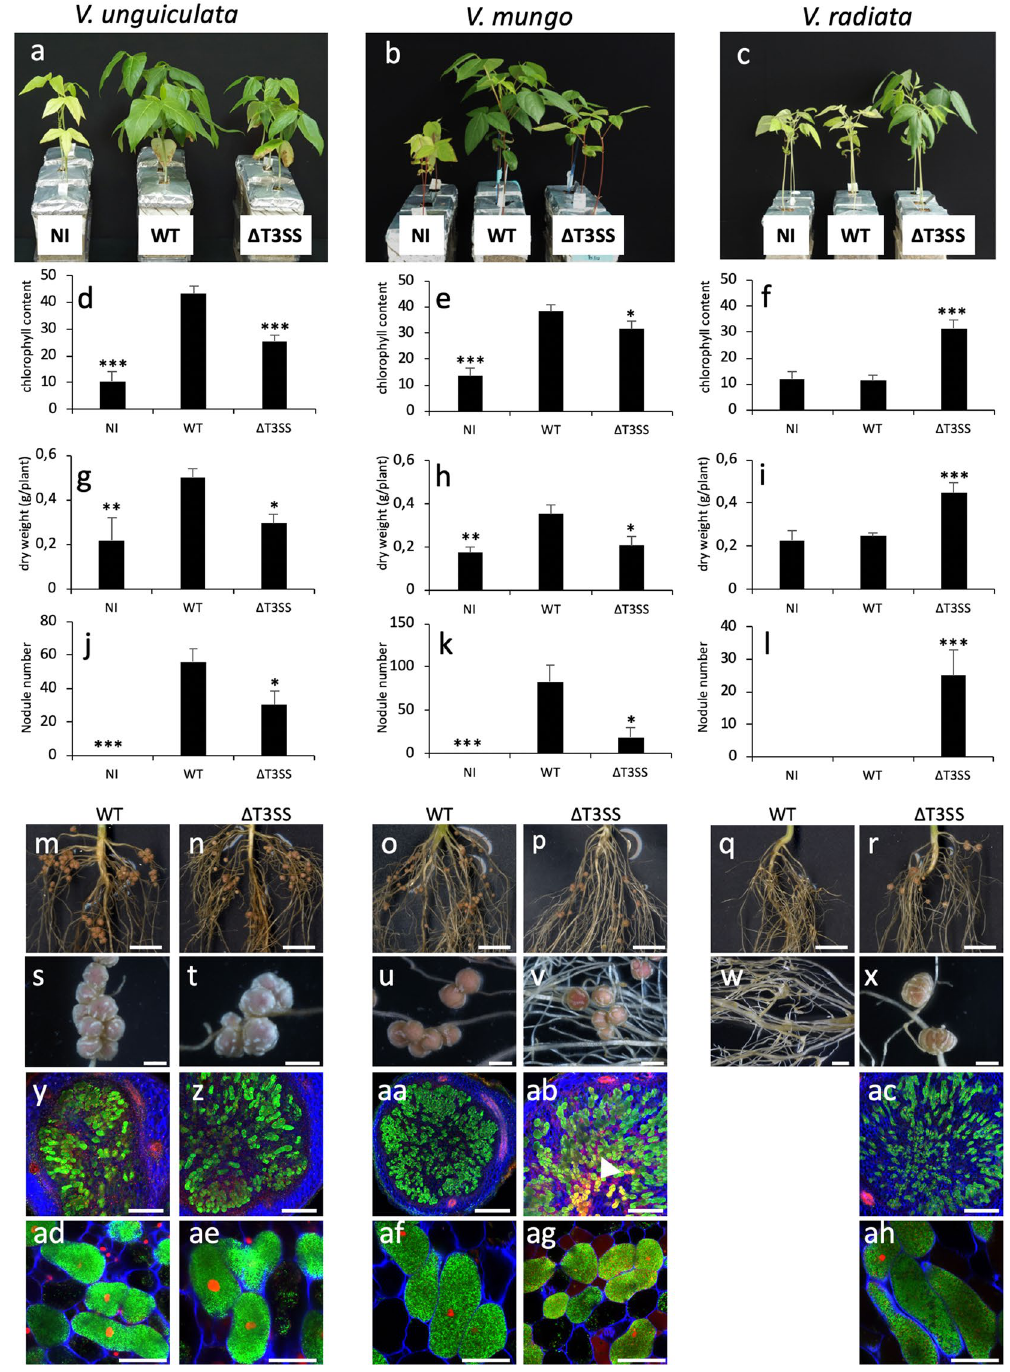
Figure 1. Symbiotic properties of Bradyrhizobium vignae ORS3257 strain (WT) and its derivative T3SS mutant (∆T3SS) in different Vigna species. ( a – c ) Comparison of the growth of the plants (aerial part), non-inoculated (NI) or inoculated with ORS3257 wild-type strain (WT) or its derivative T3SS mutant (∆ T3SS ) at 21 days after inoculation; ( d – f ) Leaf chlorophyll content; ( g – i ) Plant dry weight; ( j – l ) Number of nodules per plant. The experiment was carried out in duplicate with five plants per condition. *P < 0.05, **P < 0.01, and ***P < 0.001, significant differences between WT ORS3257 and the T3SS mutant using a nonparametric Kruskal–Wallis test. ( m – x ) View of the root and the nodules induced by ORS3257 strain and its derivative T3SS mutant (∆ T3SS ). (Scale bars, m to r, 1 cm; s to x, 2 mm). ( y – ah ) Cytological analysis of the nodules induced by strain WT ORS3257 and ∆T 3SS observed by confocal microscopy after staining with SYTO 9 (green: live bacteria), calcofluor (blue: plant cell wall), and propidium iodide (red; infected plant nuclei and dead bacteria or bacteria with compromised membranes). (Scale bars, y to ac, 200 µm; ad to ah, 50 µm). White arrowhead in AB shows the necrotic